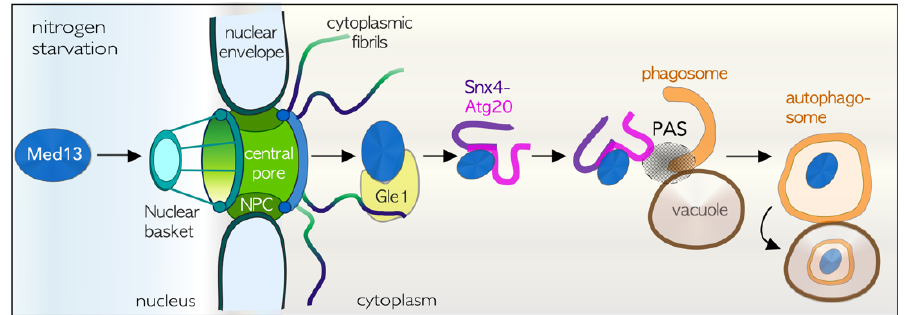
Figure 4. Upper panel: Outline of the Snx4-assisted autophagy pathway of transcription factors. This pathway transports Med13 from the nucleus to the vacuole for proteolysis following TORC1 inhibition. NPC—nuclear pore complex, PAS—Pre-autophagosomal structure.